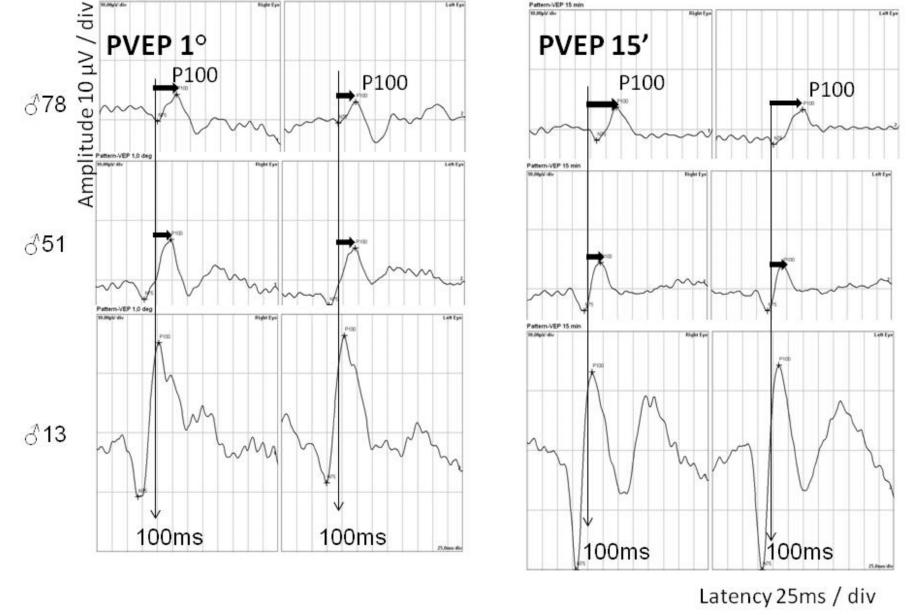
Figure 7. Pattern visual evoked potentials (PVEP) in patients from three generations. P100 wave amplitude within normal age range; P100 wave latency delayed (filled arrow). The results of the ophthalmological examinations of healthy boys were